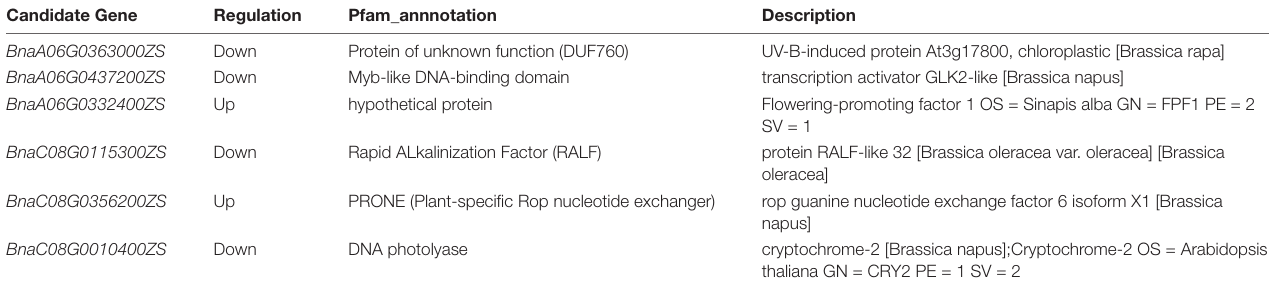
TABLE 5 | Candidate genes narrowed down by QTL-mapping and RNA-seq experiments and their annotations. Candidate